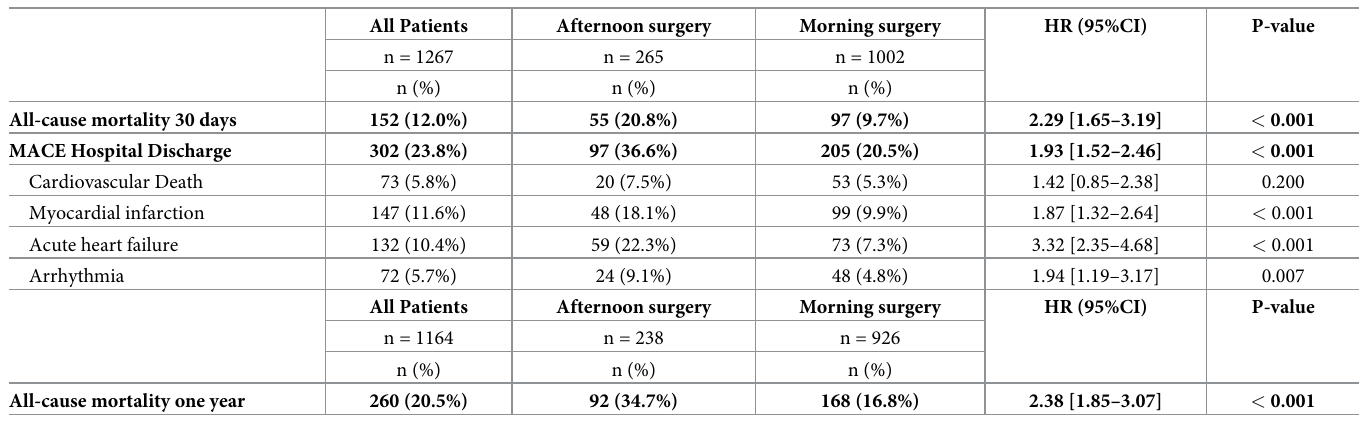
Table 2. All-cause mortality after 30 and one year of follow-up and MACE.